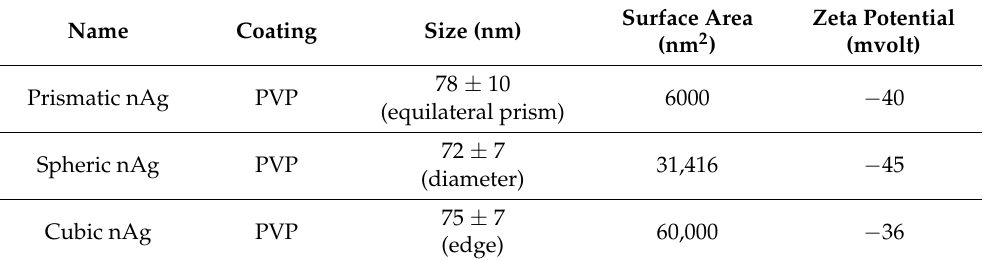
Table 1. Silver nanoparticle